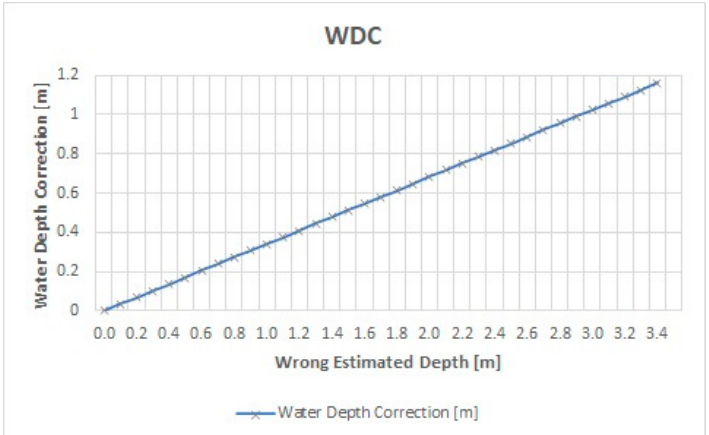
Figure 6. Water Depth Correction parameter.